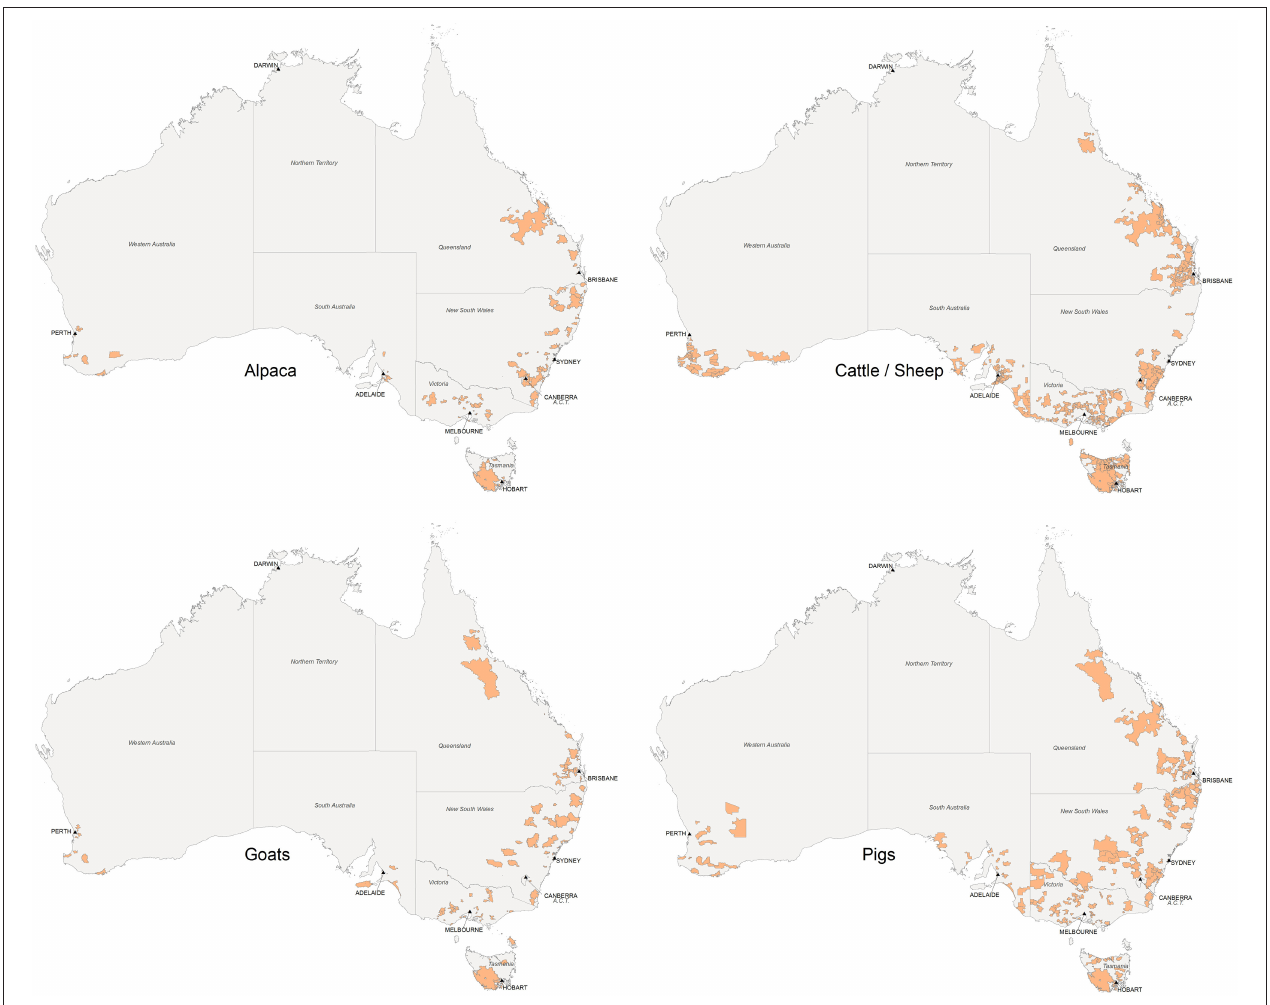
FIGURE 1 | Location by postcode of smallholders participating in a cross-sectional study in Australia in 2013–2015, according to species